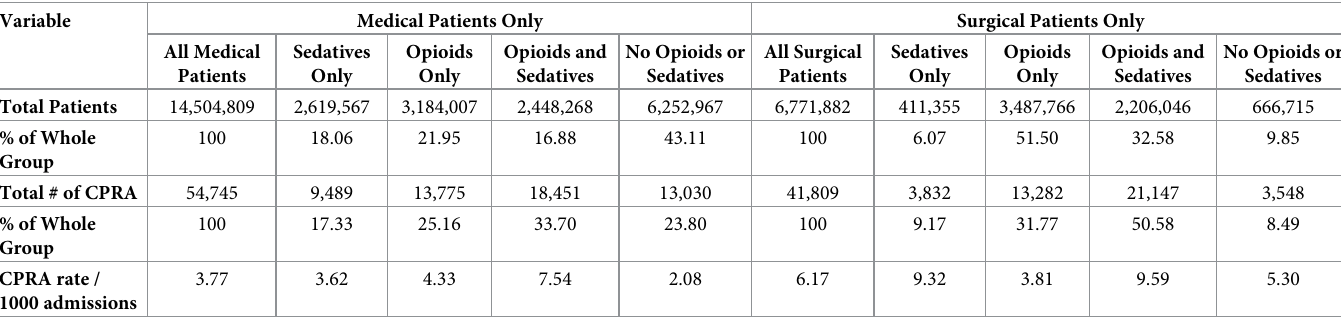
Table 1. Incidence of CPRA in medical vs. surgical patients on sedatives, opioids, both sedatives and opioids, or neither sedatives nor opioids. Variable Medical Patients Only Surgical Patients